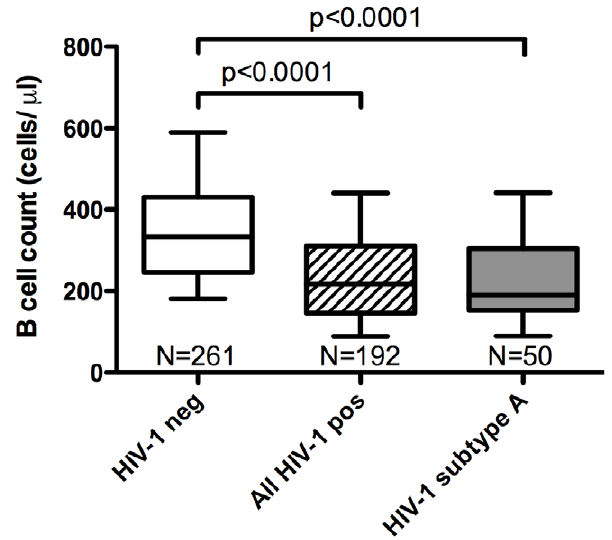
Figure 1. The absolute B lymphocyte count in HIV-1 subtype A infected patients is significantly lower than in HIV-1 negative controls. Samples of whole blood from HIV-1 infected and uninfected individuals were analysed using flow cytometry and the MultiTEST TM IMK Kit (BD). Lymphocyte subpopulations were quantified and samples from 261 HIV-1 negative individuals (white box) were compared with HIV positives. The absolute counts of CD19 + B lymphocytes in 50 HIV-1 subtype A infected patients (grey box) and in 192 patients with all HIV-1 subtypes combined (hatched box) were significantly reduced in comparison to uninfected participants. (p , 0.0001, Mann-Whitney test). The whiskers represent the range from the 10th–90th percentile.